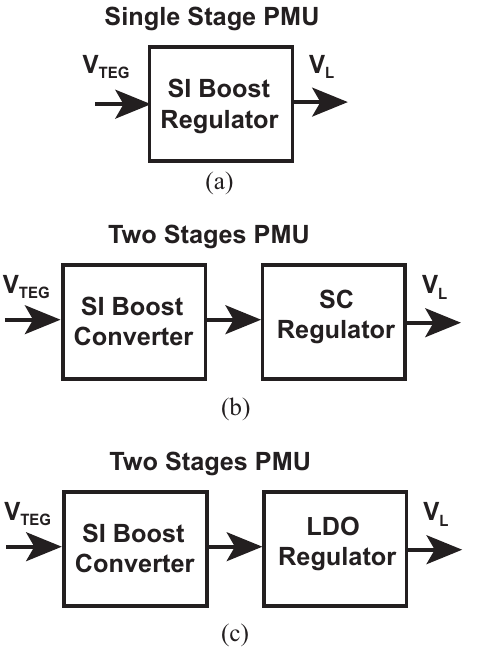
Figure 14. ( a ) Proposed single stage PMU using SI boost regulator, ( b ) two stages PMU using SI boost converter followed by SC regulator, ( c ) two stages PMU using SI boost converter followed by LDO regulator. Table 3. Comparison between single and two stages